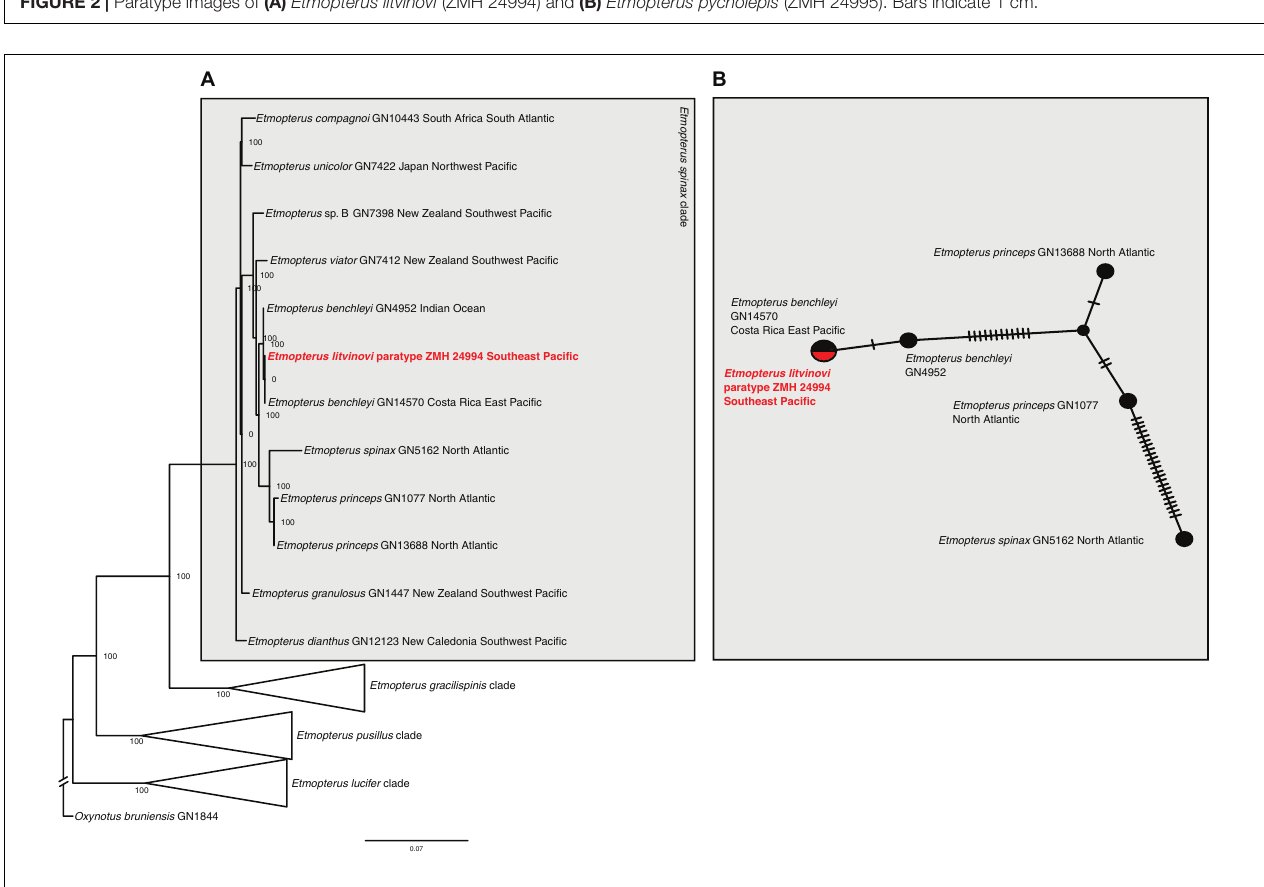
0.07 FIGURE 3 | (A) Maximum likelihood analysis of Etmopterus 12s and 16s rRNA sequences. Numbers at nodes denote bootstrap support values. Oxynotus bruniensis was chosen as outgroup. (B) Haplotype network of 12s and 16s rRNA sequences including sequences from the E. litvinovi paratype, E. benchleyi and its sister clade comprising E. princeps and E. spinax . Crossbars indicate mutational steps. E. litvinovi and E. benchleyi GN14570 share a haplotype, GN4952 differs in a single mutational step.